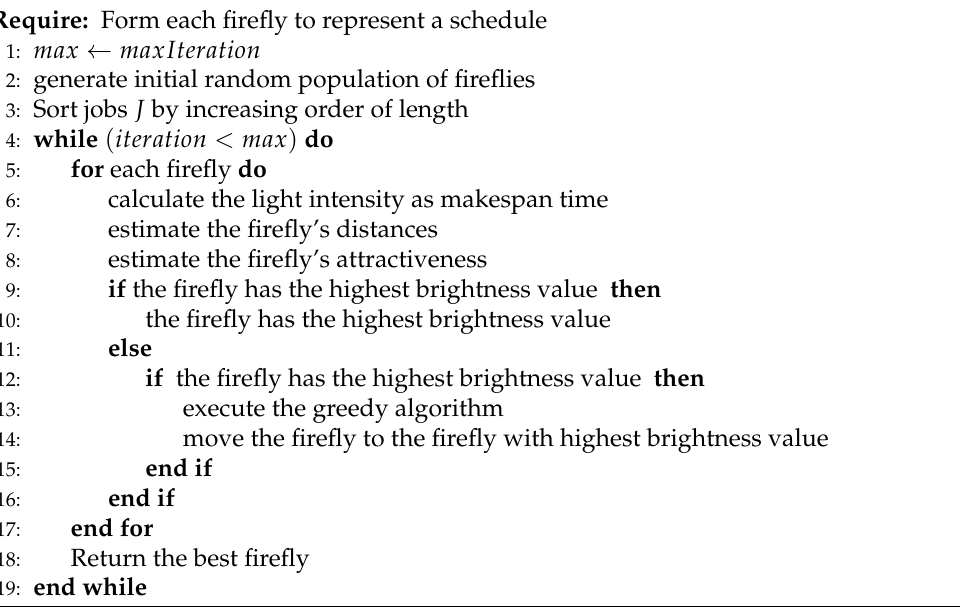
Algorithm 2 Firefly Algorithm for Job Scheduling.